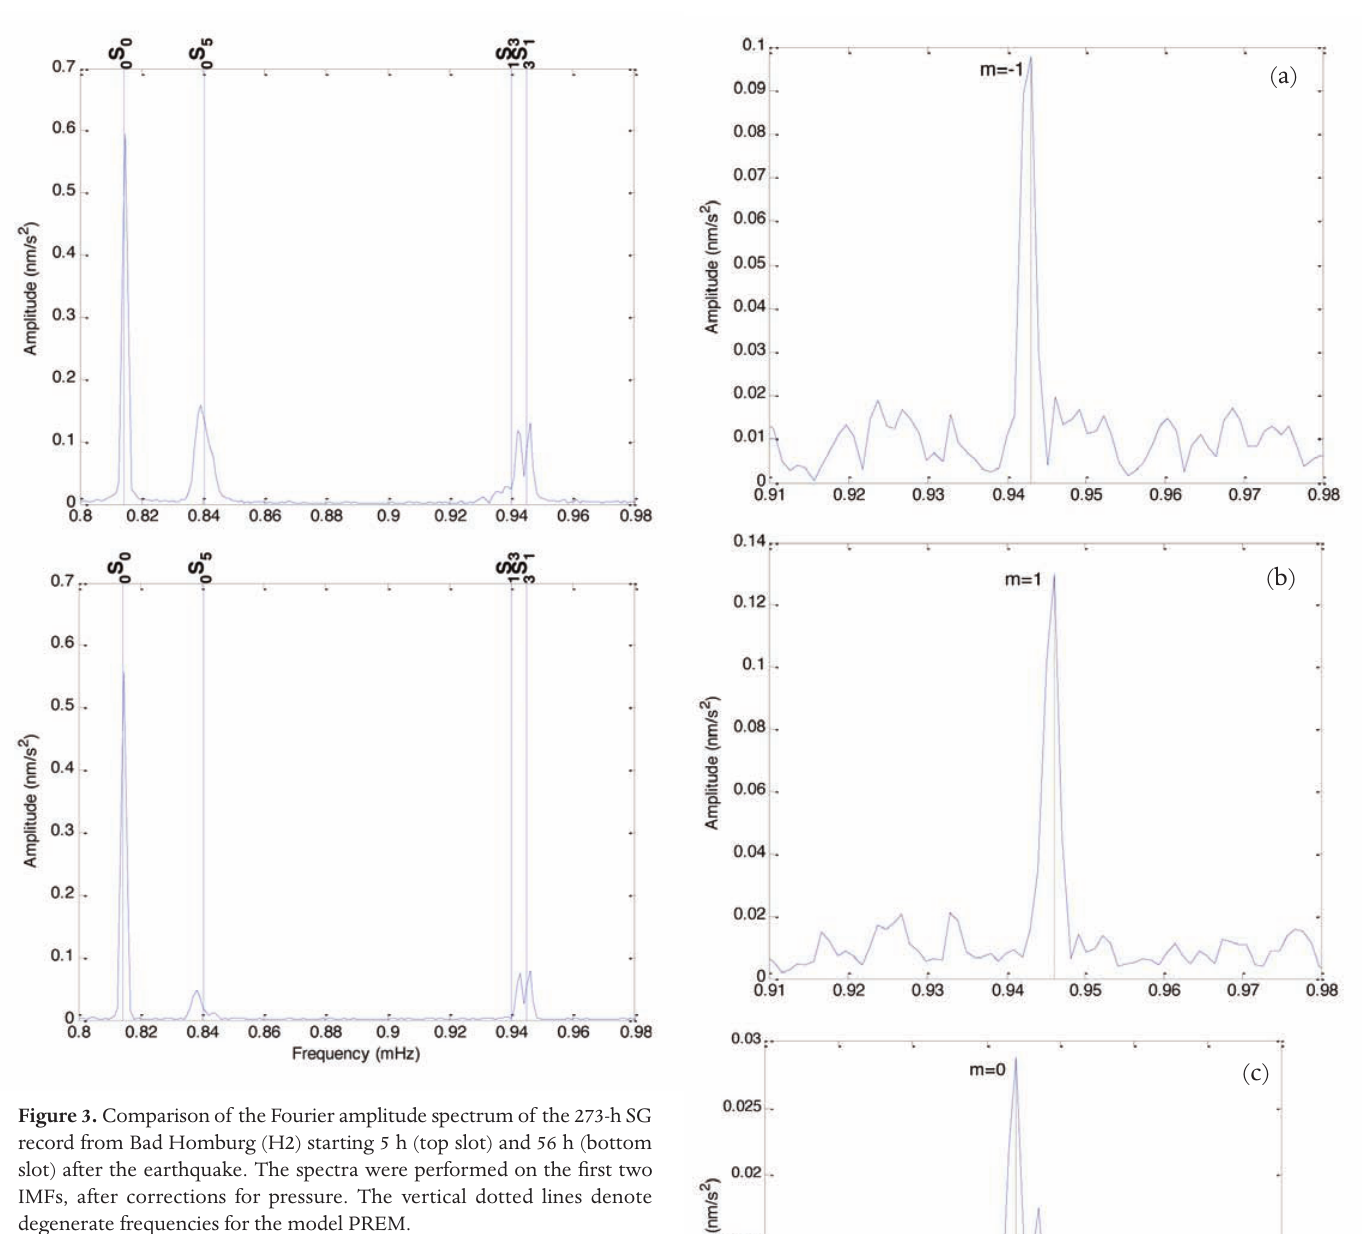
Figure 4. Amplitude spectra of the three singlets of the mode 3S1 obtained from the multi-station experimental analysis technique. (a) m =–1. (b) m =1. (c) m